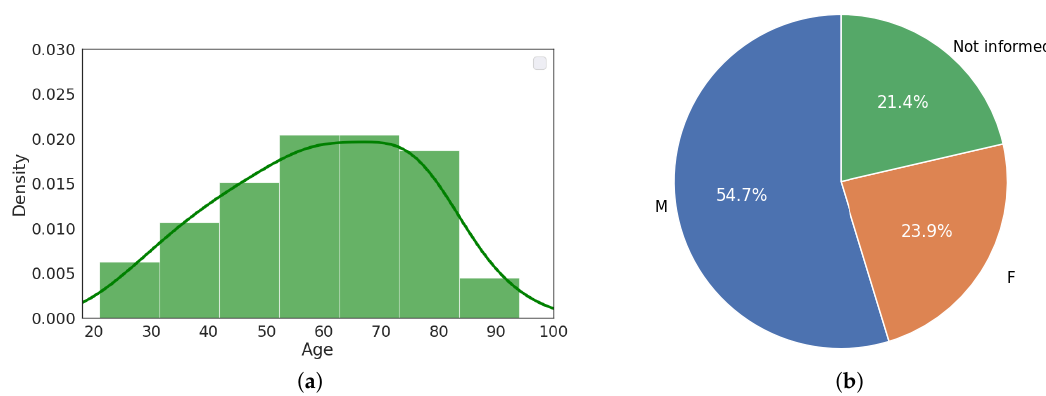
Figure 13. Metadata provided by the COVID-19 reference dataset. Age histogram ( a ) and gender pie chart ( b ). Source: prepared by the authors.